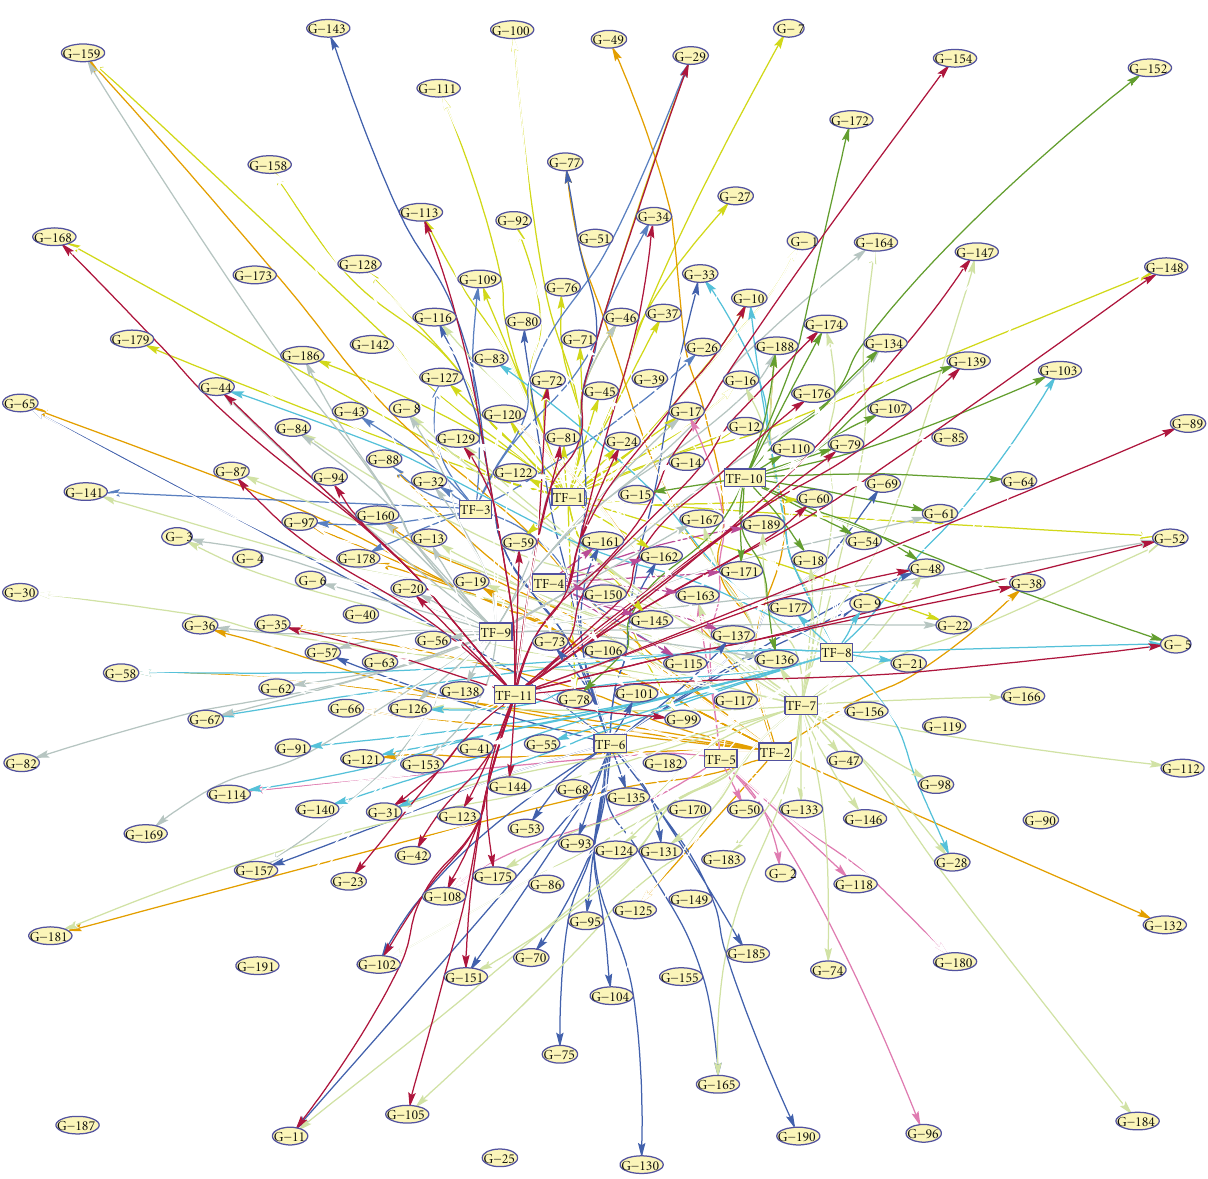
Figure 11: Transcriptional regulatory network in ER −